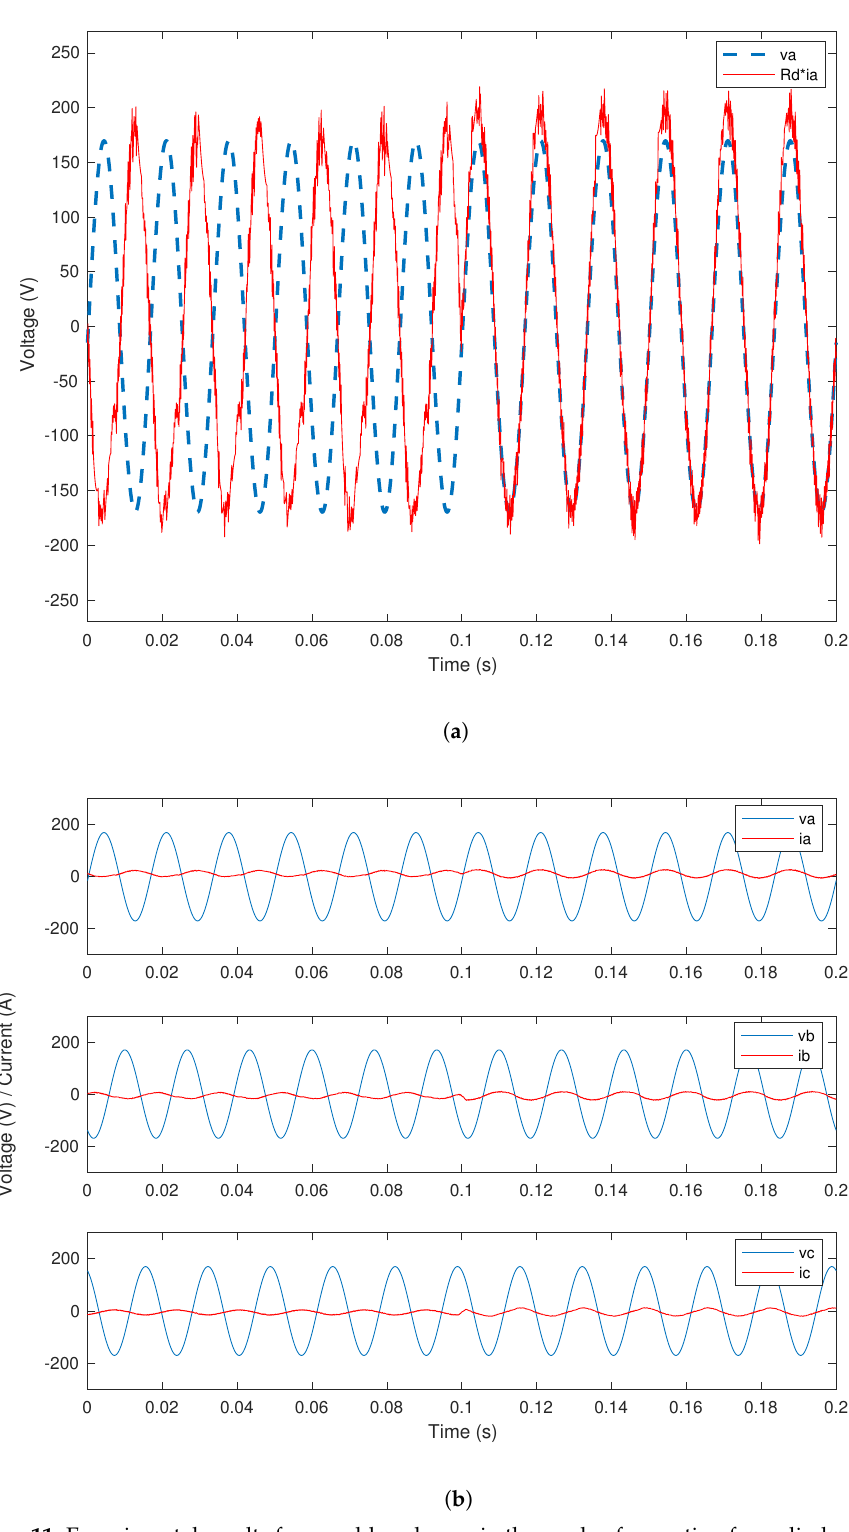
Figure 11. Experimental results for a sudden change in the mode of operation from discharging when R d = − 10 Ω to charging mode when R d = 10 Ω . ( a ) The voltage of Phase-a and its current multiplied by R d . ( b ) The input voltage and current of each